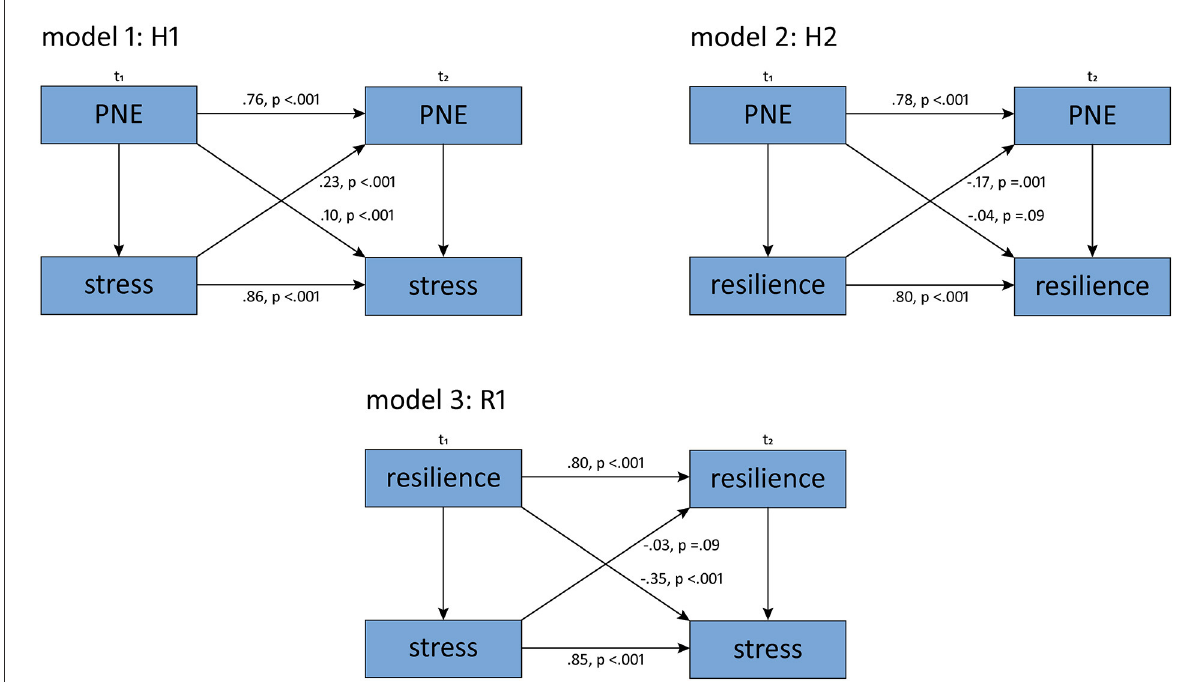
FIGURE3 Standardized regression coefficients and p -values from the SEM for all three models. H1, hypothesis 1; H2, hypothesis 2; R1, research question 1; t 1, time 1; t 2, time 2; PNE, pharmacological neuroenhancement.